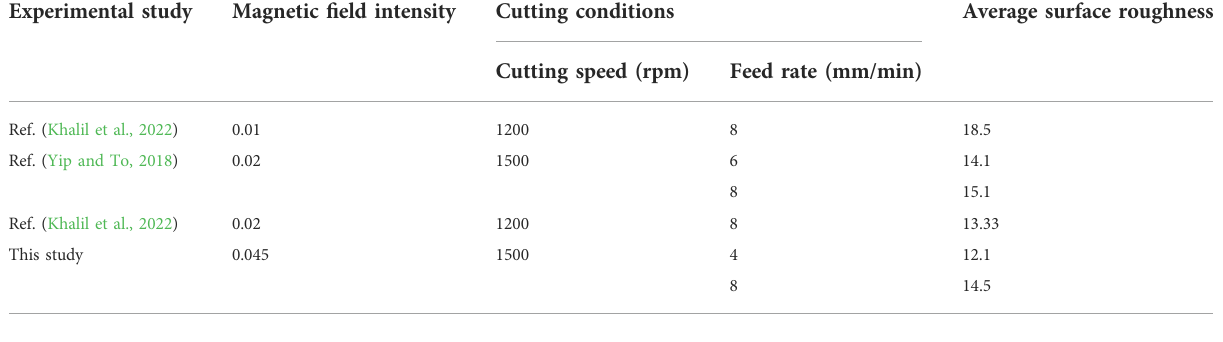
TABLE 3 Evaluation of the effect of applying a magnetic fi eld on the quality of surface fi nish:The results of experimental studies and improvement of the generated surface roughness compared to turned samples without magnetic fi eld assistance in dry cutting conditions. Experimental study